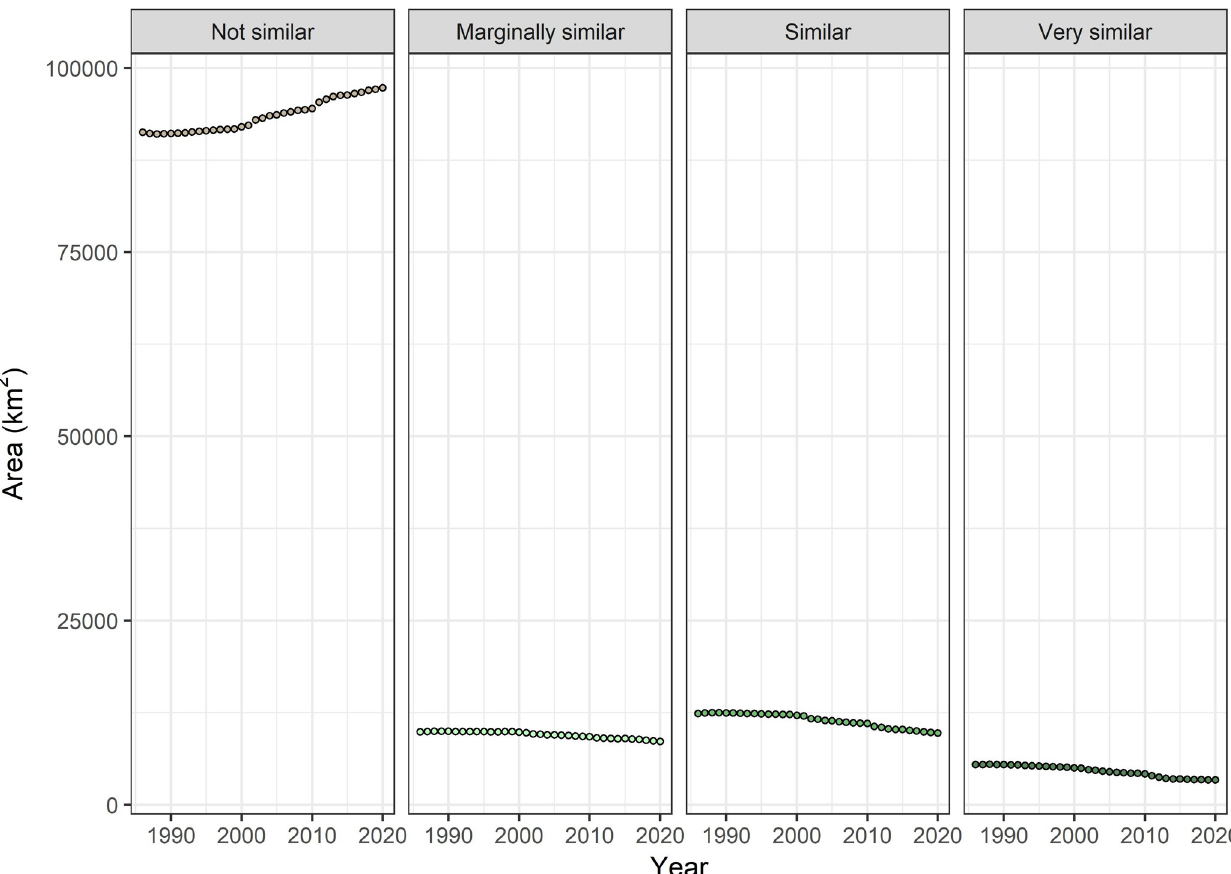
Fig 6. Temporal trends in mapped spectral similarity classes over a 35-year period. Dashed line shows a linear fit over the study period with equation and R 2 values shown in each panel.